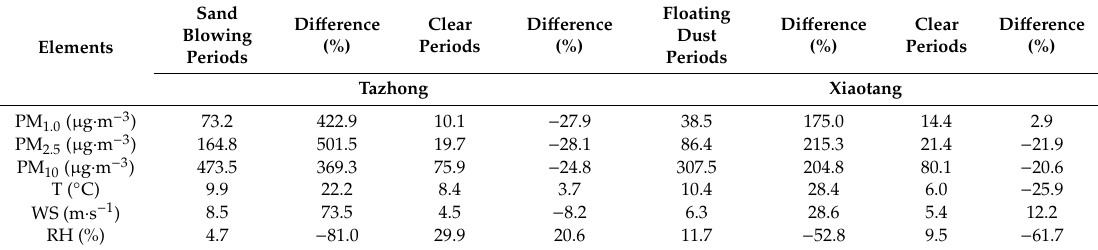
Table 2. Mean values and the percentage of di ff erence for each place and the TD recorded during the sand blowing, floating dust, and clear